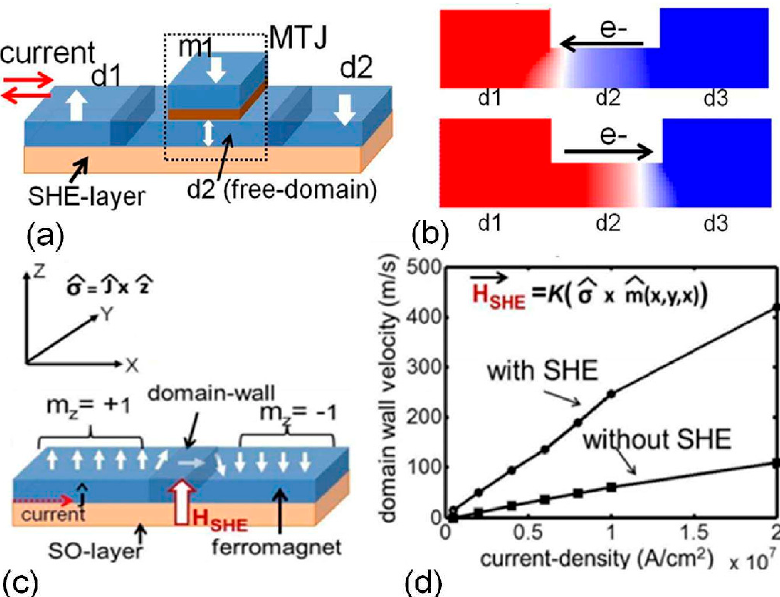
Figure 1. ( a ) Spin neuron with three terminals based on the domain wall motion depicted in ( b ), ( c ) contribution from the spin Hall effect (SHE) to speed up domain wall motion, ( d ) resulting domain wall motion as a function of current density. Reprinted with permission from [14]. Copyright (2018) by AIP Publishing.